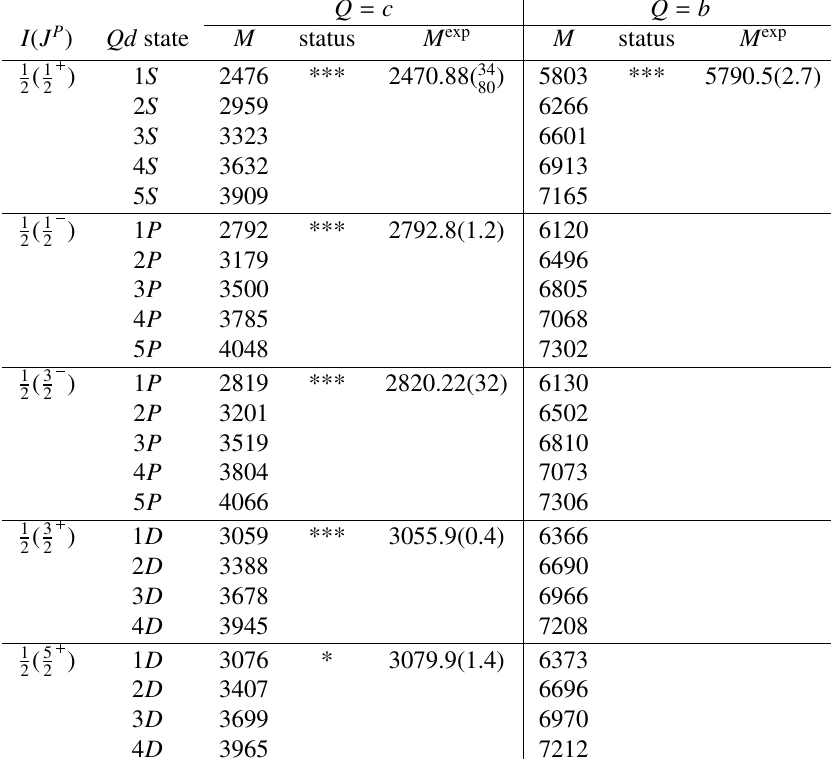
Table 3. Masses of the Ξ Q ( Q = c , b ) heavy baryons with the scalar diquark (in